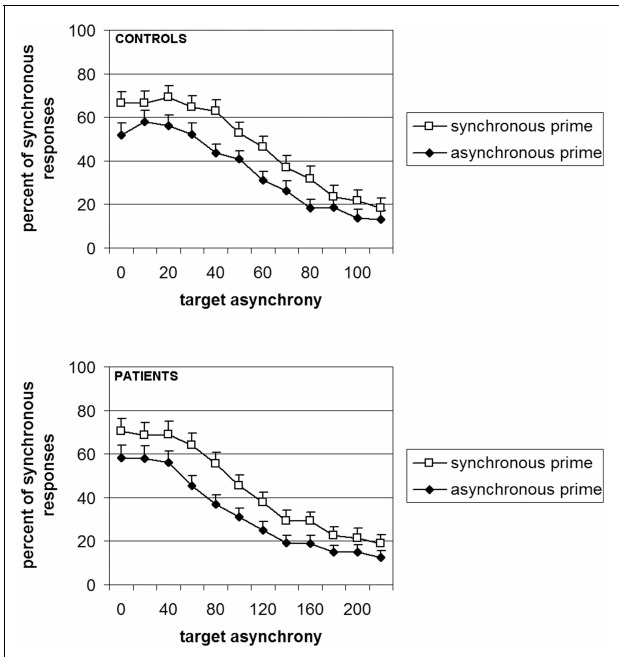
FIGURE 2 | Percent of responses “simultaneous” as a function of the prime (white squares = synchronous vs. black diamonds = asynchronous) and the group (controls in the upper panel and patients in lower panel) . It is to be noted that the abscissa is the double for patients as compared to controls, thus illustrating the difficulty of the patients to emit a judgment in this experiment (with the permission of Schizophrenia